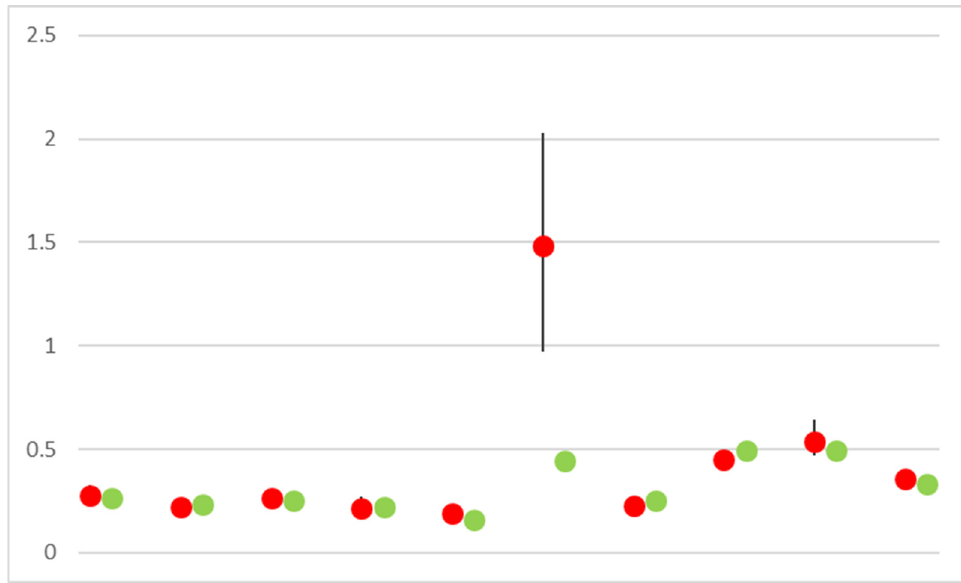
Figure 4. Benzene concentrations (in µ g/m 3 ) in the classrooms (minimum—arithmetic mean— maximum, in red) and in front of the school (one sampling point per school, in